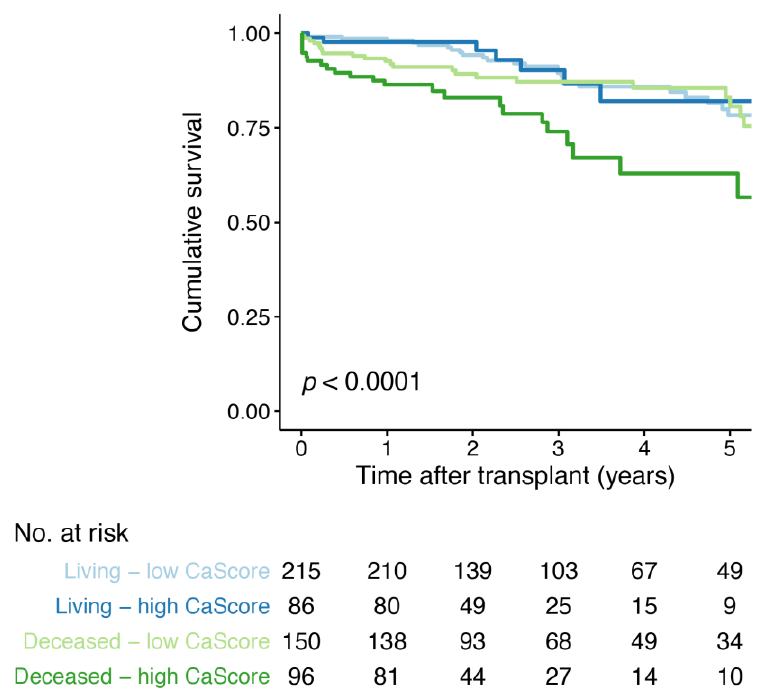
Figure 4. Kaplan–Meier survival curve for graft function decline free-survival for the low and high aorto-iliac CaScore group, stratified by living and deceased donor kidney transplantation. Number at risk (No. at risk) provided for all four groups.